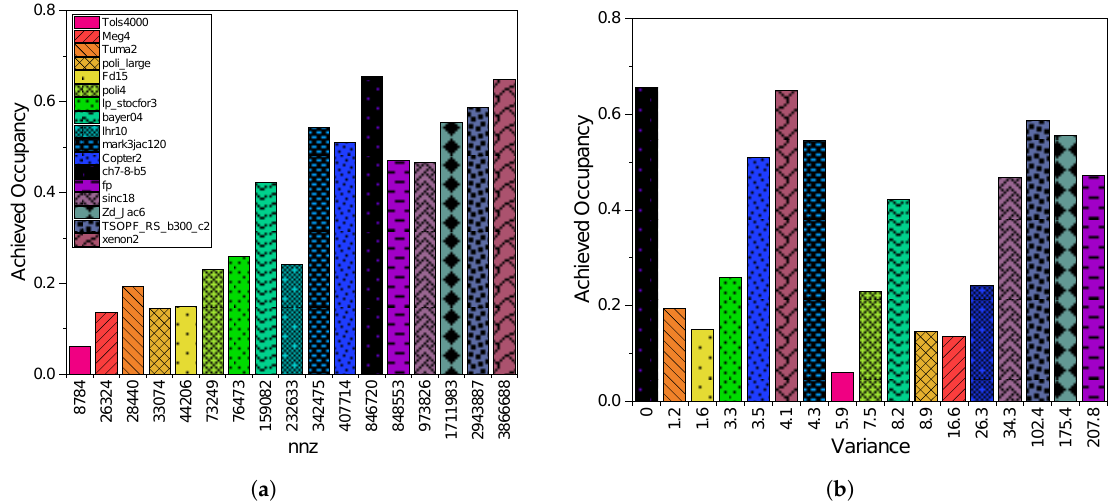
Figure 18. CSR5 achieved occupancy against: ( a ) nnz and ( b ) npr variance